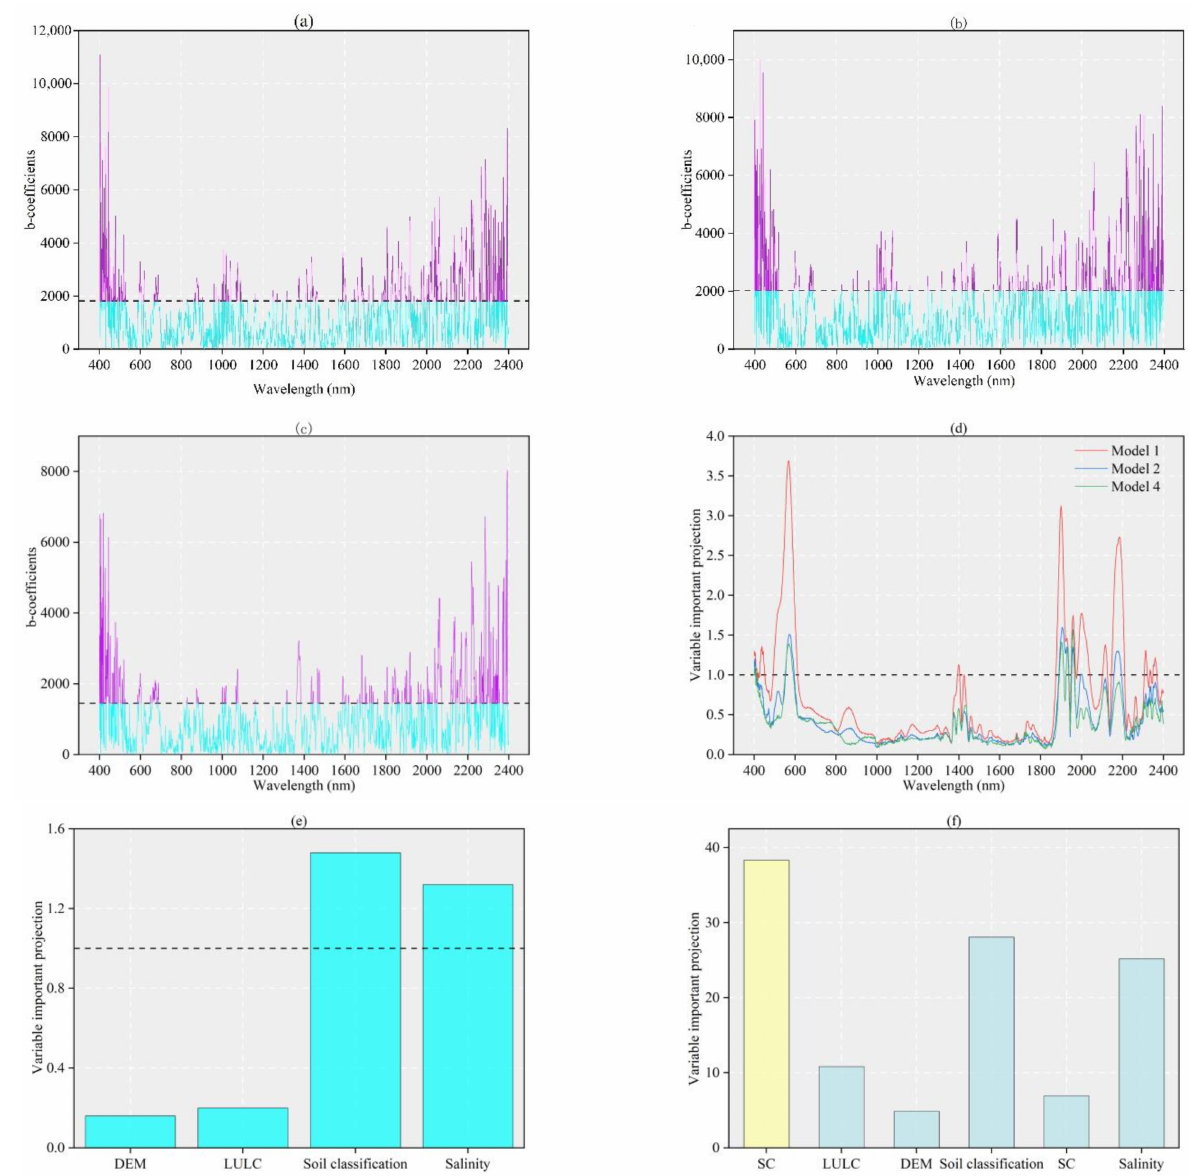
Figure 7. VIP scores for the b-coefficients and environmental covariates based on PLSR cross- validation models; ( a – c ) show the b-coefficients, in which the dashed lines are the thresholds for the b-coefficients, and ( a ) = 1813.84, ( b ) = 2019.01, and ( c ) = 1447.63. ( d – f ) show VIP scores for the auxiliary variables, and the dashed line is the critical value of the VIP score; ( a ) Model 1, ( b ) Model 2, ( c ) Model 4, ( d ) scores of spectra in Model 1, Model 2, and Model 4, ( e ) scores of auxiliary variables in Model 3, and ( f ) scores of auxiliary variables in Model 2 and Model 4. (First yellow bar represents SC in model 2 and the fifth blue bar represents SC in model 4.) SC-Spectral